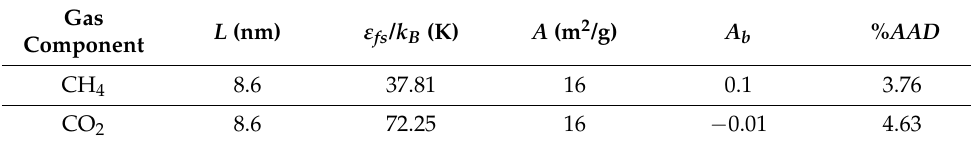
Table 2. Regression parameters and % AAD for pure gas